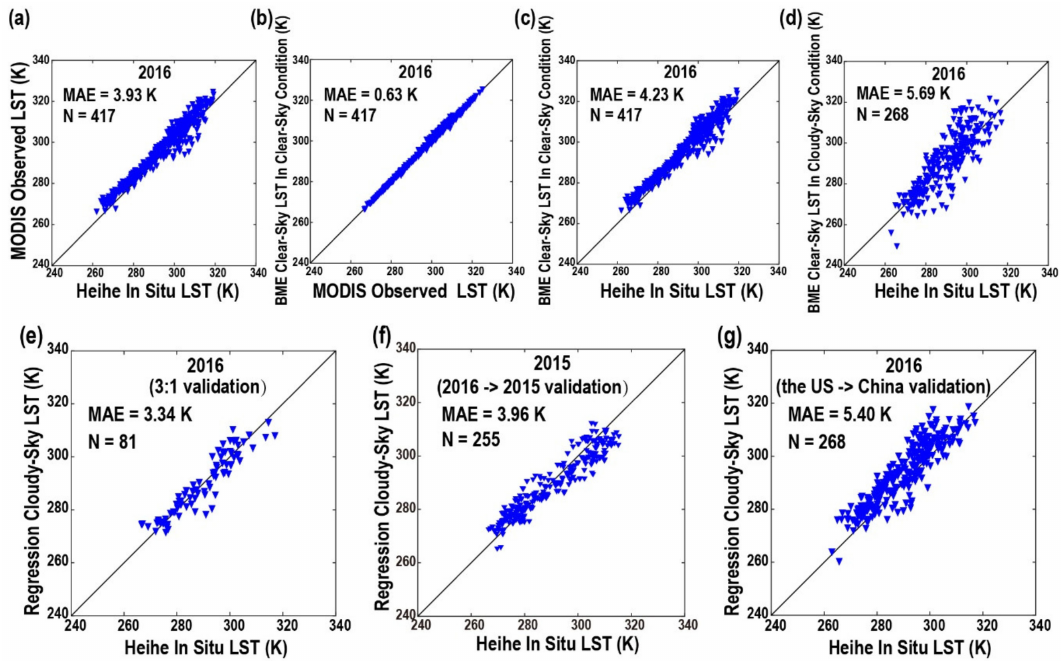
Figure 9. Scatter plots in 2016 of ( a ) MODIS-observed LST versus Heihe in situ LST, ( b ) BME clear-sky LST in clear-sky condition versus MODIS observed LST, ( c ) BME clear-sky LST in clear-sky condition versus Heihe in situ LST, ( d ) BME clear-sky LST in cloudy-sky condition versus Heihe in situ LST, ( e ) regression cloudy-sky LST versus Heihe in situ LST (data from 2016 were randomly split into training and validation datasets at a ratio of 3:1), ( f ) regression cloudy-sky LST versus Heihe in situ LST (data from 2016 were used for training datasets and 2015 data for validation datasets), and ( g ) regression cloudy-sky LST versus Heihe in situ LST (applying the 2016 regression coe ffi cients in the US to